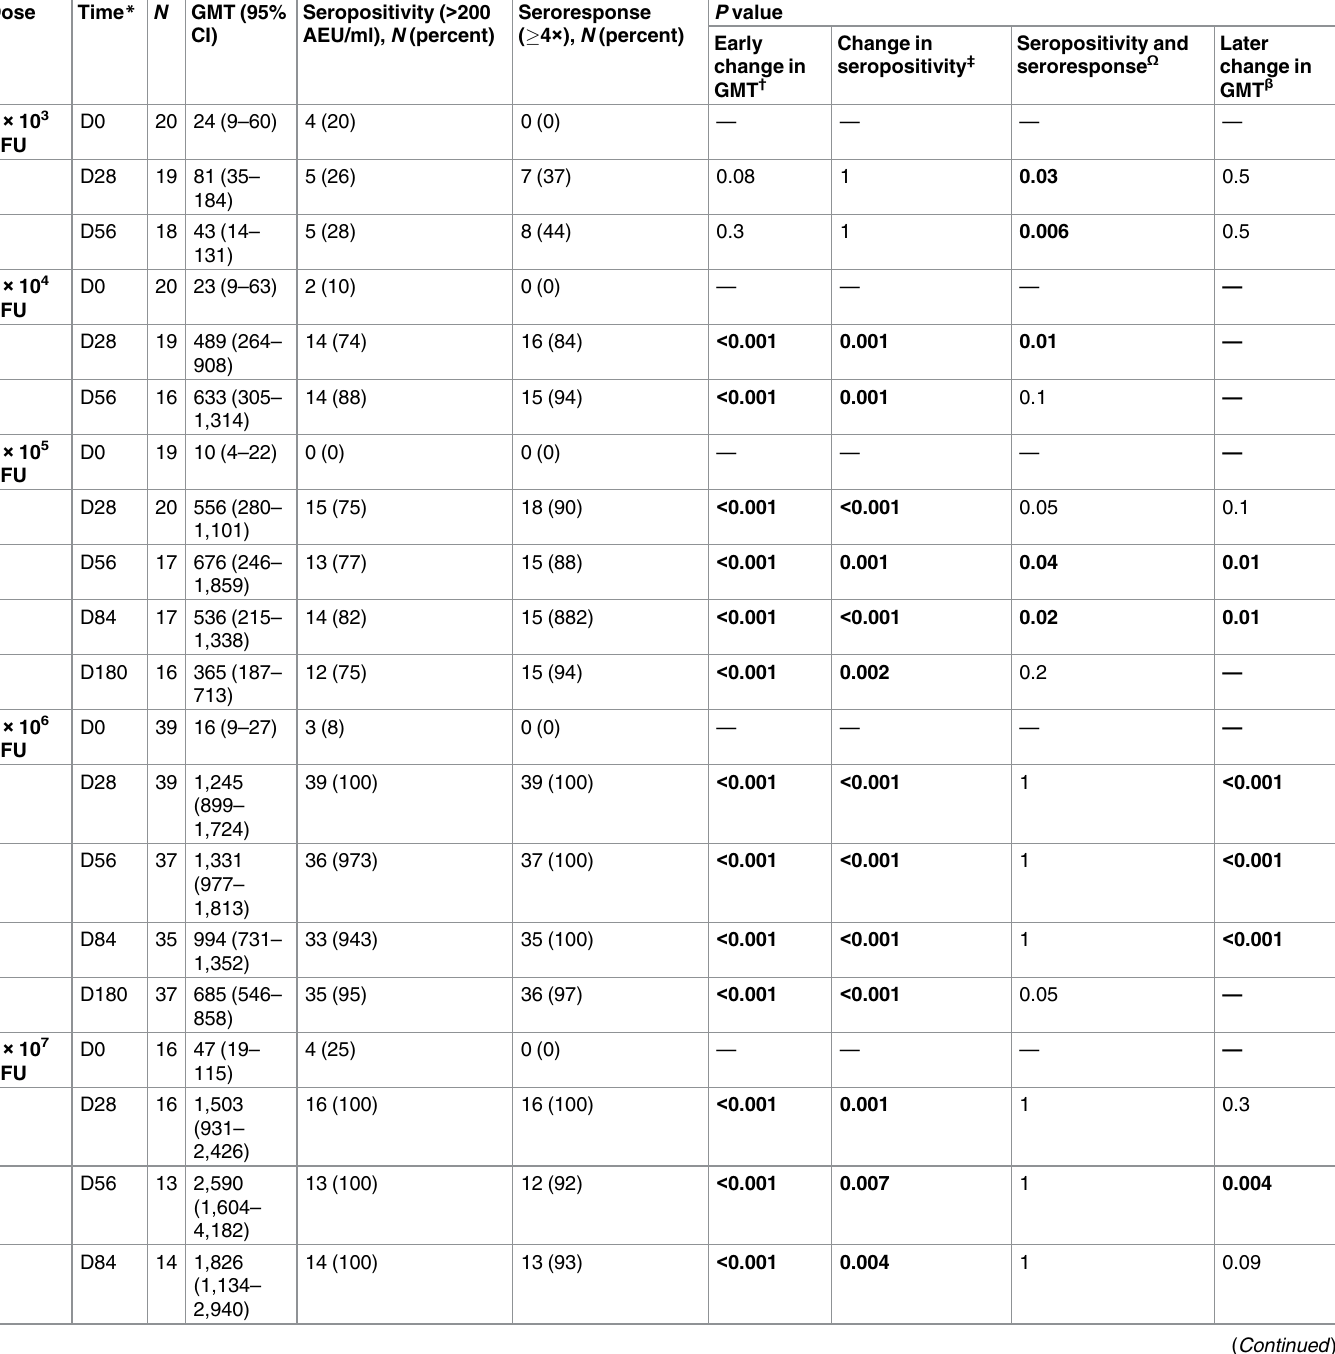
Table 3. Endpoint geometric mean titres, seropositivity rates, and proportions of seroresponders to rVSV Δ G-ZEBOV-GP measuredby ZEBOV-GP ELISA in adults. Dose Time * N GMT (95%